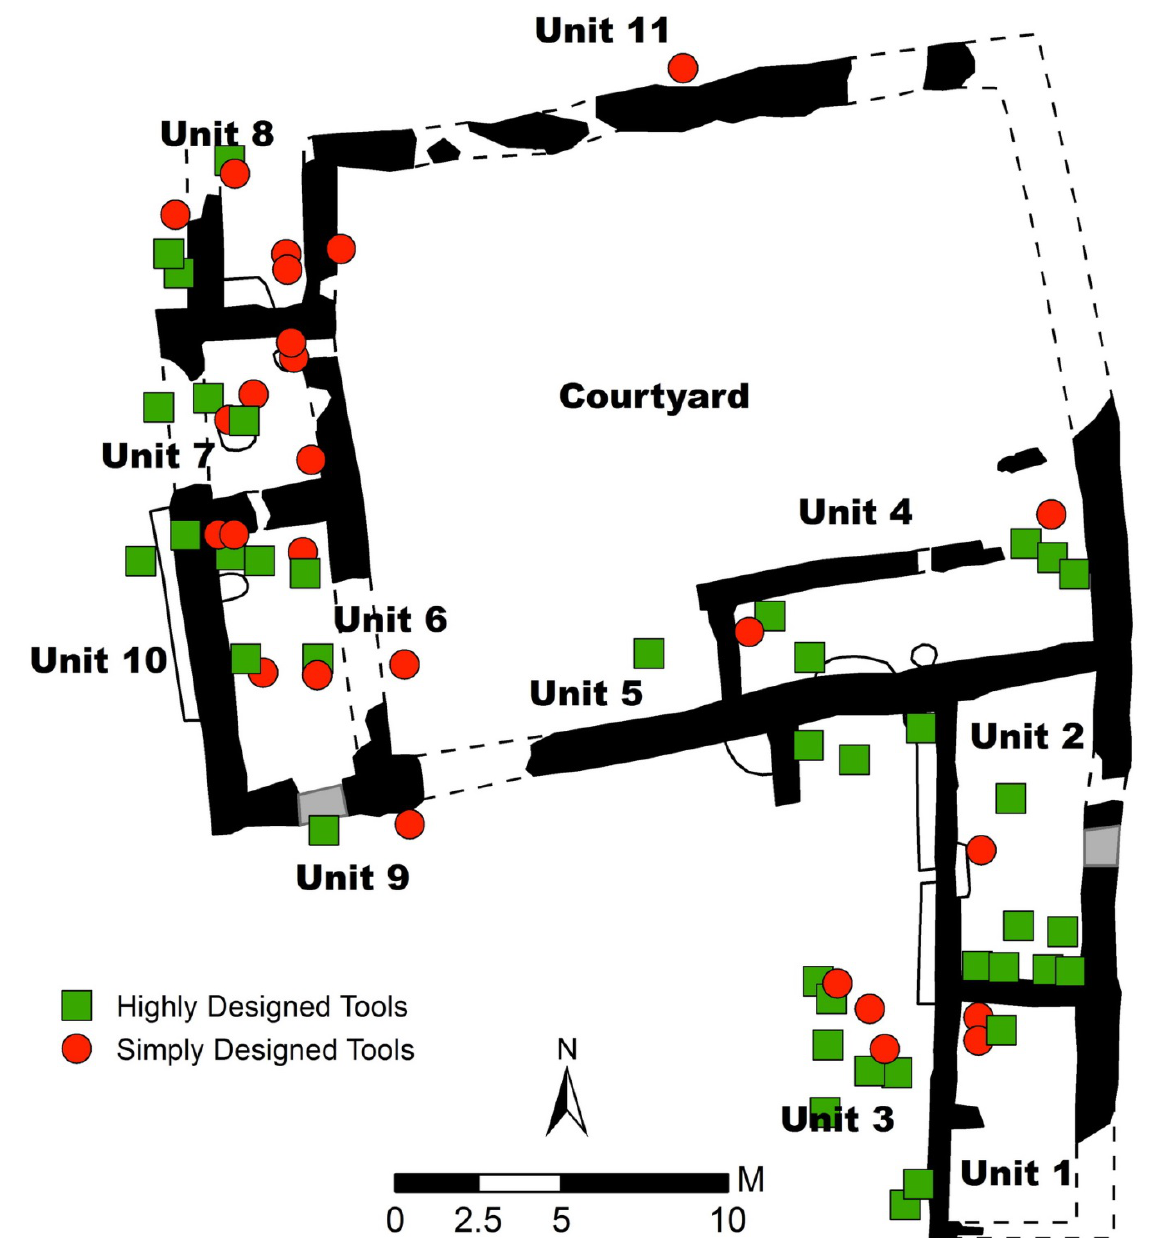
Figure 8. Distribution of ground stone tool level of design in Fazael 2 (excluding basalt bowls and spindle whorls, which are strategically designed by